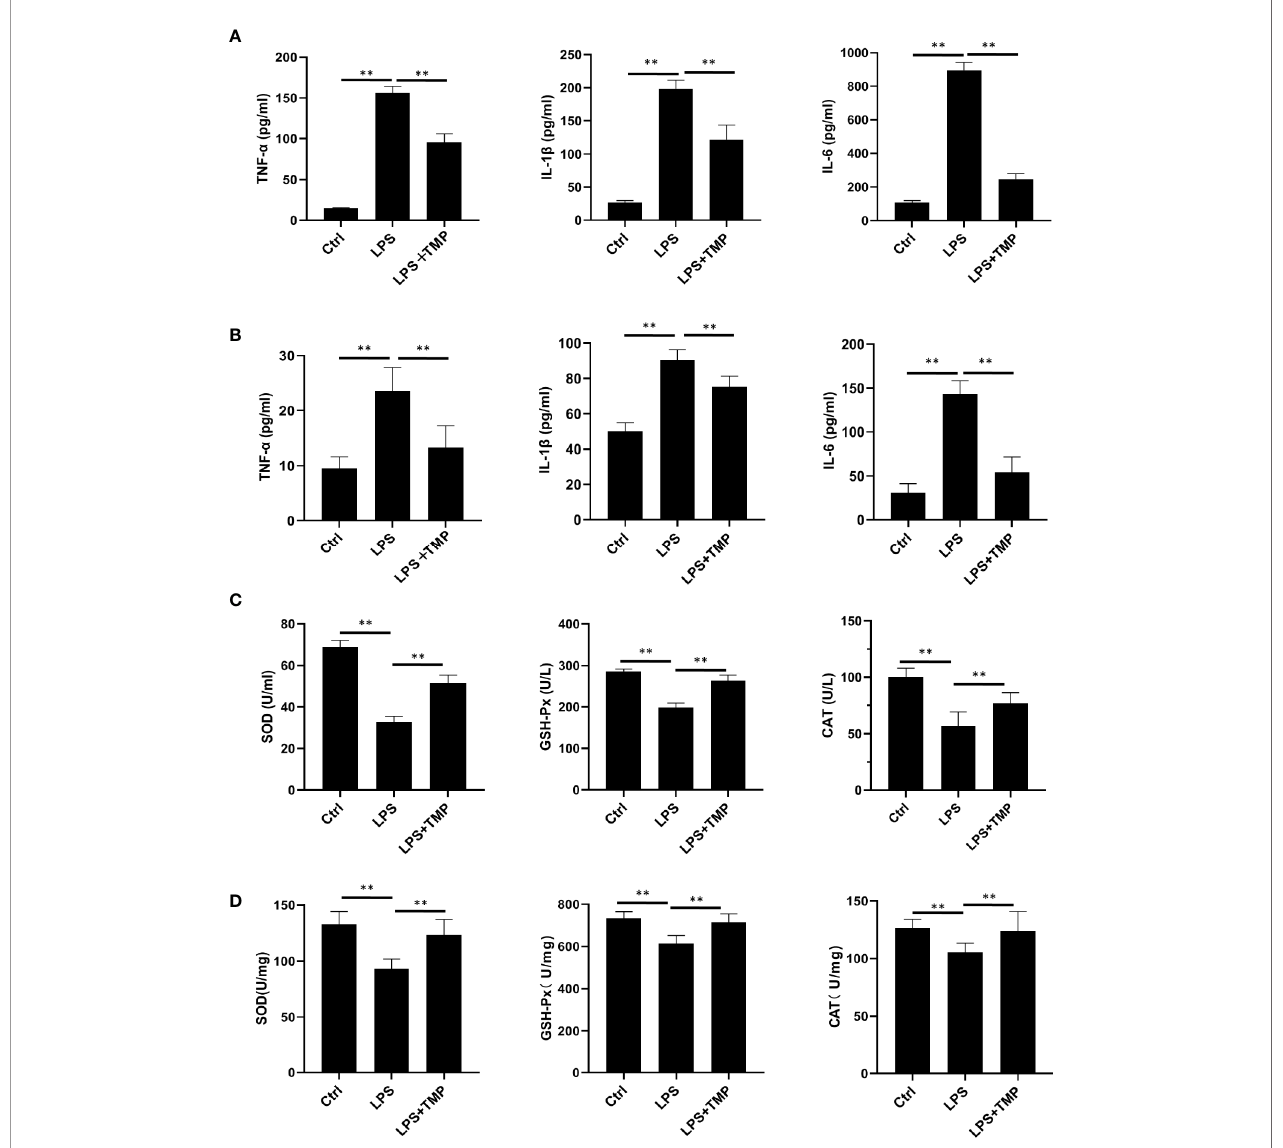
FIGURE 3 | Effect of TMP on the in fl ammatory cytokines and antioxidant enzymes in the serum of septic rats ( n =8). (A) The expression level of in fl ammatory factors in serum. (B) The Expression levels of in fl ammatory cytokines in rat lung lavage fl uid. (C) The expression levels of antioxidant enzymes in Serum. (D) The expression levels of antioxidant enzymes in lung tissue. Compared with the LPS group, ** P <